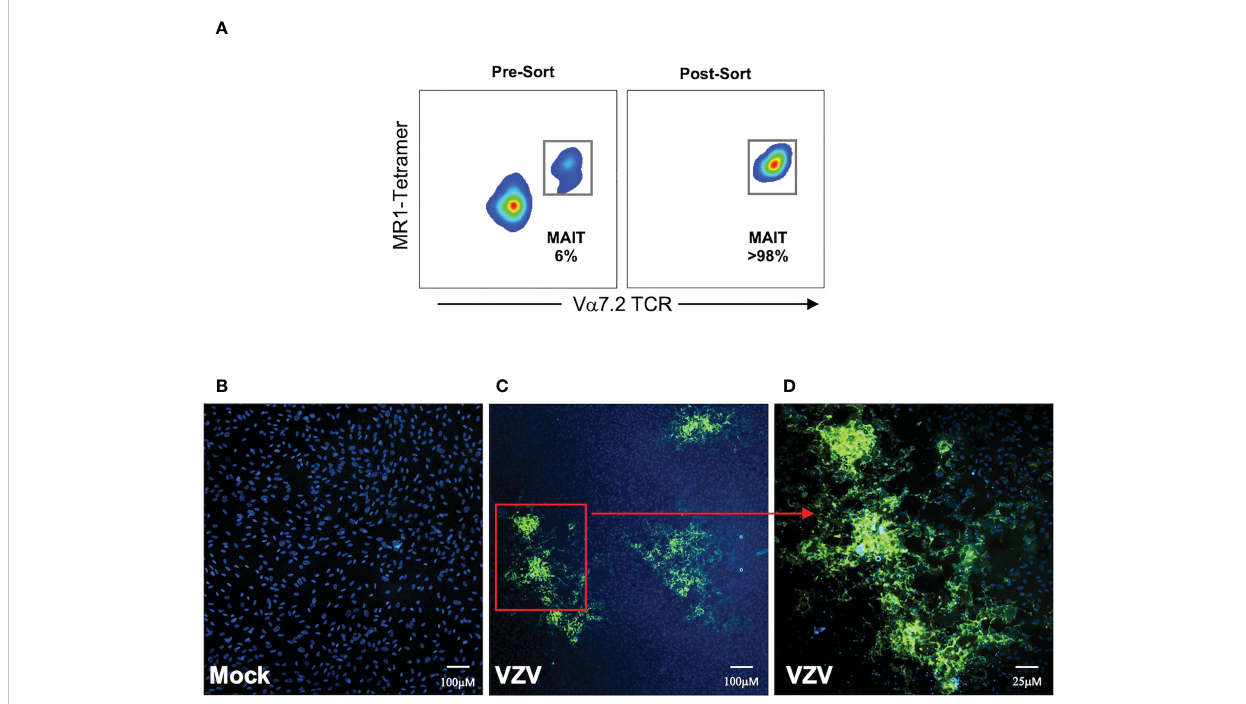
FIGURE 6 MAIT cells support de-novo viral replication and virus transmission. Human PBMCs were inoculated with mock or a GFP-tagged VZV infected ARPE- 19 epithelial cells for 2 days and then FACS sorted for MAIT cells (CD3 + MR1-Tetramer + V a 7.2 + ). (A) Representative fl ow cytometry plot depicts MAIT cell frequencies of total live lymphocytes pre- and post-sorting. (B, C) Sorted mock or VZV-GFP exposed MAIT cells were citrate buffer washed three times and then added to ARPE-19 epithelial cell monolayers at a ratio of 1 sorted MAIT cell to 5 epithelial cells. Co-cultures were incubated at 37°C 5% CO 2 and fi ve days later monolayers were fi xed, counterstained with DAPI and infectious centers visualized by the detection of VZV-GFP by fl uorescent microscopy. Representative images (from four replicate experiments) of ARPE-19 monolayers exposed to (B) mock infected MAIT cells or (C) , inset in (D) VZV-GFP exposed MAIT cells are